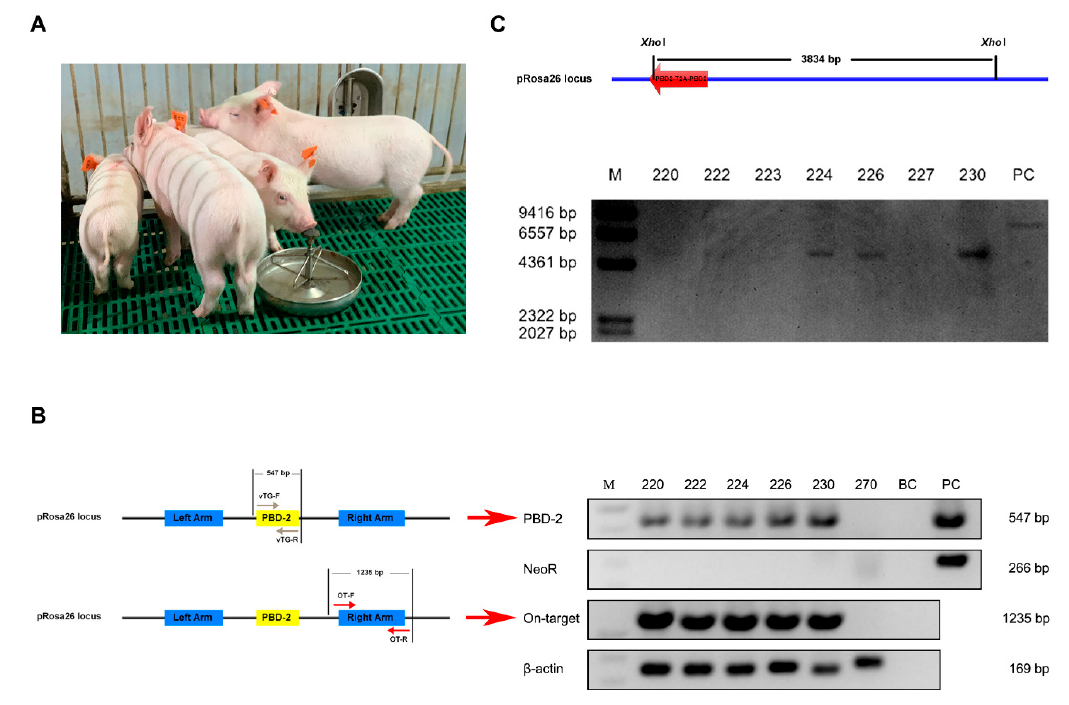
Figure 2. Genotyping of cloned piglets. ( A ) Physical appearance of cloned piglets. ( B ) PCR analysis